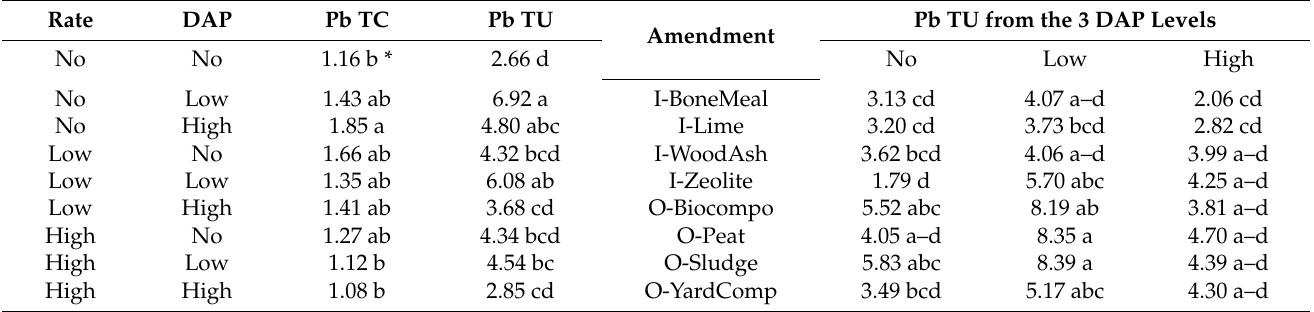
Table 5. Mean Pb tissue concentration (Pb TC in mg kg − 1 ), and Pb tissue uptake (Pb TU mg kg − 1 ) obtained from the 9 combinations of Amendment Rate and DAP (Rate*DAP interaction effect) and Pb TU obtained from 24 combinations of Amendment and DAP (Amendment*DAP interaction effect).